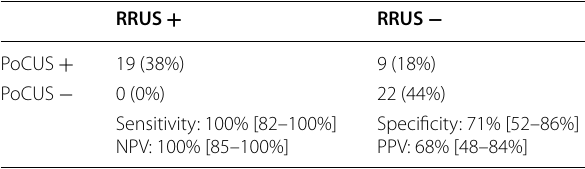
Table 1 Results of PoCUS compared with RRUS for hydro- nephrosis in 50